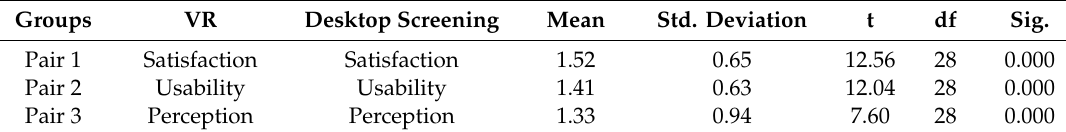
Table 4. Paired ‐ sample t test between three levels of satisfaction, usability, and media perception. Groups VR Groups